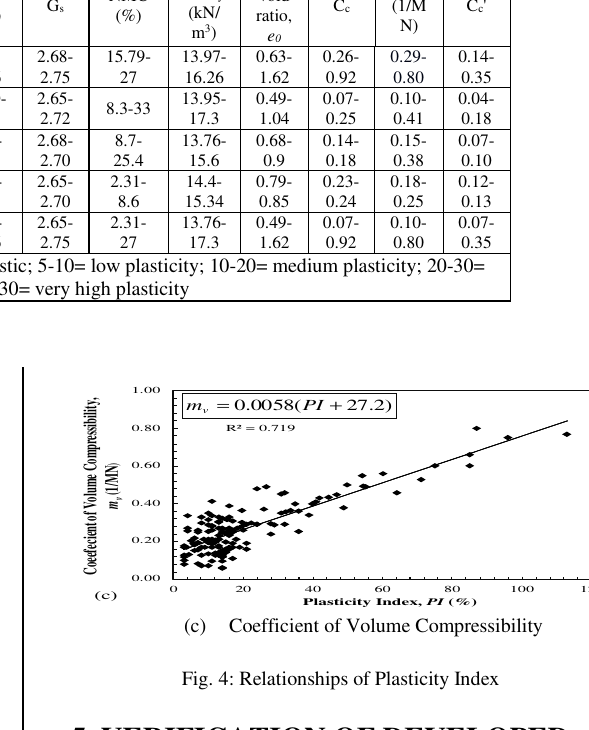
Fig. 4: Relationships of Plasticity